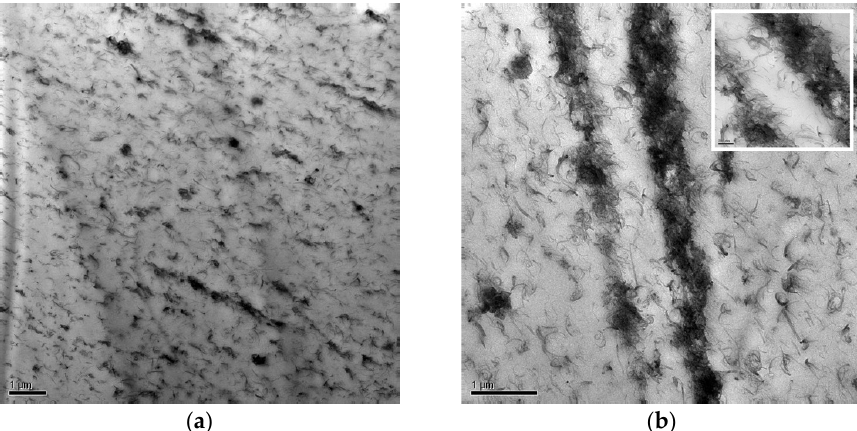
Figure 4. TEM images of the PFPE ‐ modified CNTs ‐ based UHMWPE with 1:1 ratio CNT:PFPE and 3% carbon content (PE ‐ CNT F2 ‐ 3). Details of the functionalized CNT spread network ( a ) and the scattered rows ( b ).